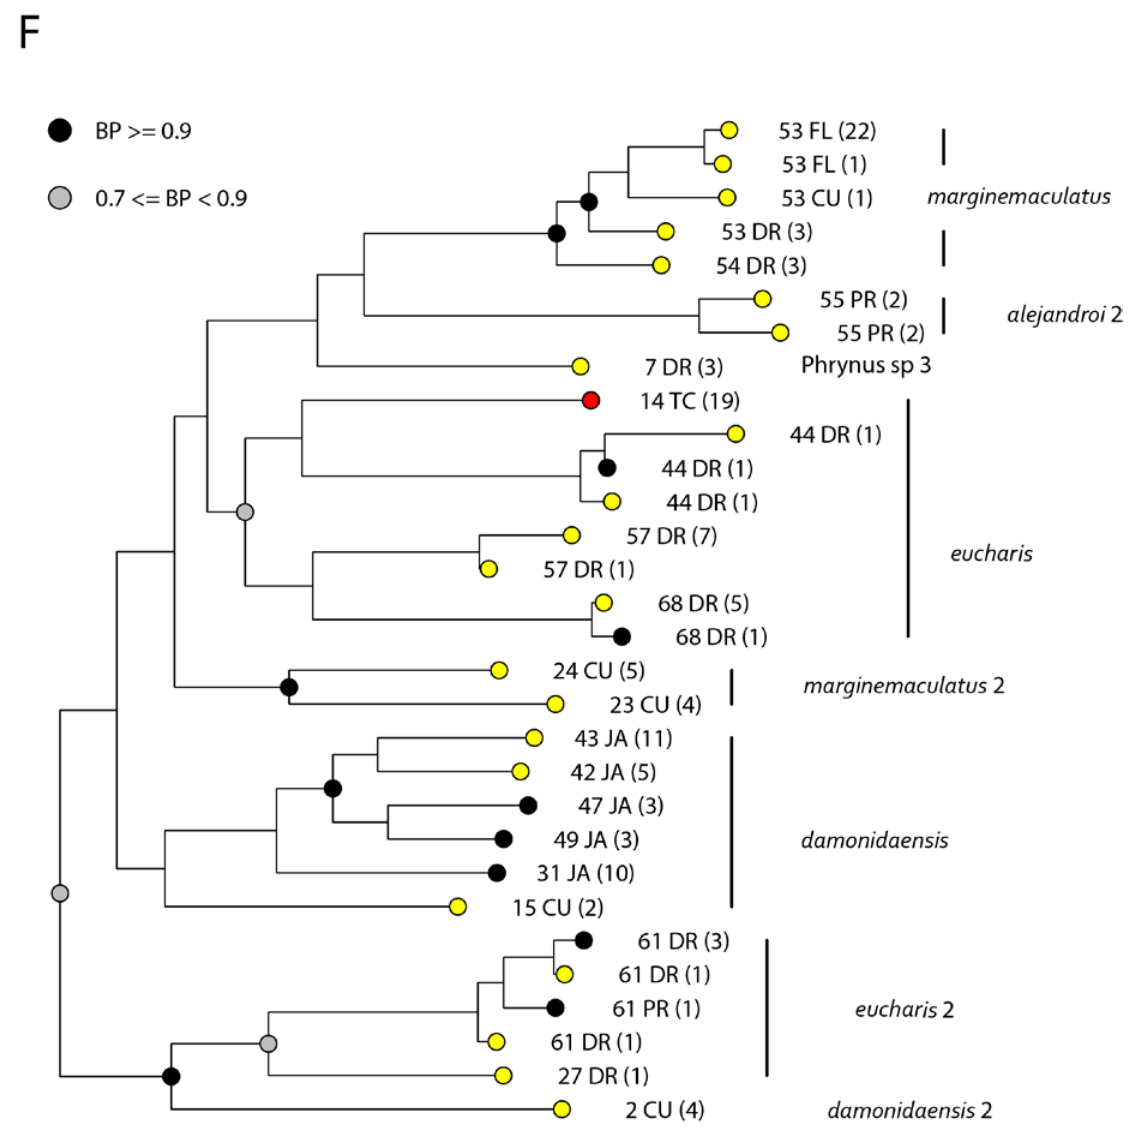
Figure 5. Details of clade F from Figure 3. Colored circles indicate habitat of each sampled species; yellow = epigean, black = cave, and red = both. Abbreviations refer to area of origin: